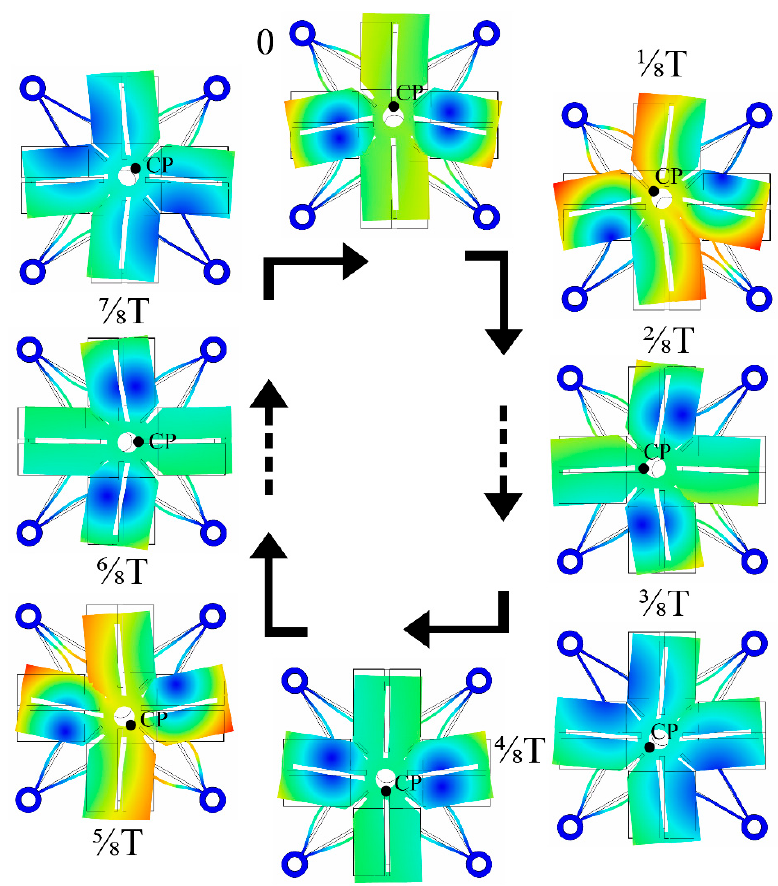
Figure 7. The operation sequence of the motor during one period; CP—contact point.